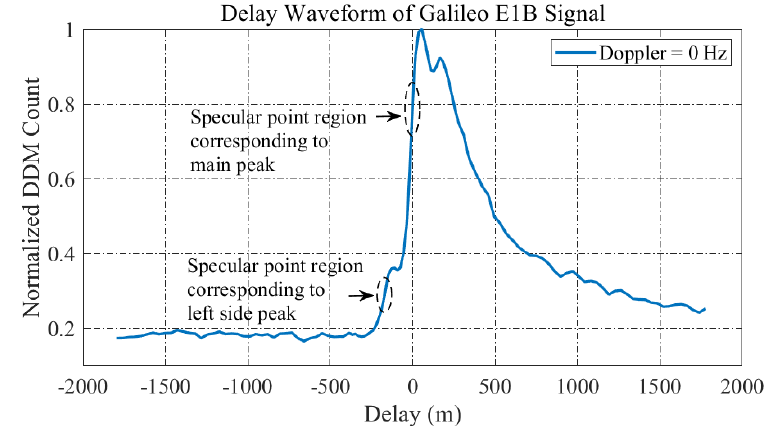
Figure 8. Delay waveform corresponding to a Doppler of 0 Hz in the DDM of the reflected Galileo E1B signal (Galileo PRN 25), generated by the GNOS-II on-board the FY-3E satellite on 11 July 2022. The specular point region corresponding to the main peak means where the main peak of the ACF of the reflected Galileo signals scatter off the specular point region plays a significant role in forming the specific waveform. The specular point region corresponding to the left side peak means where the left side peak of the ACF of the reflected Galileo signals scatter off the specular point region plays a significant role in forming the specific waveform.